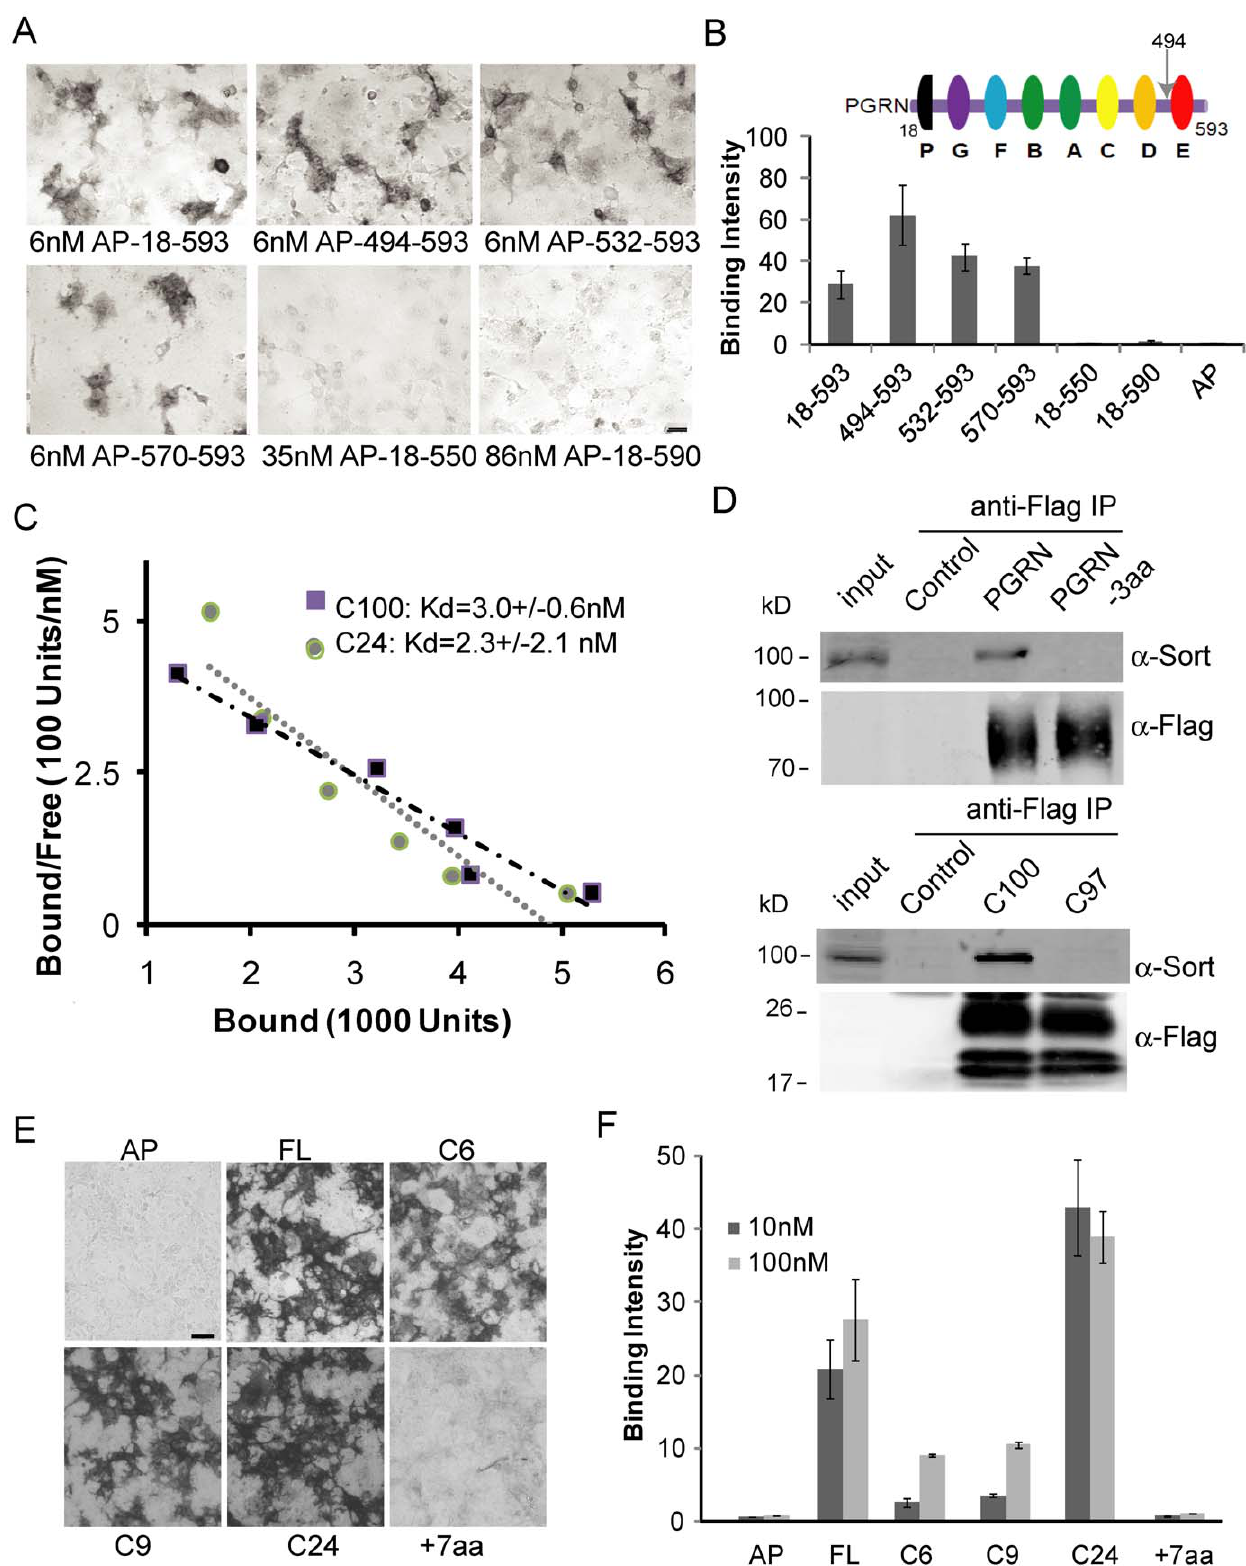
Figure 2. Progranulin C-terminus mediates its binding to sortilin. ( A ) COS-7 cells expressing wild type sortilin were allowed to bind AP tagged progranulin fragments as indicated. ( B ) Quantification of the binding assay as described in (A). The intensity of AP staining was measured using the Metaexpress software (Y axis: average integrated optical density per cell ( 6 100)). ( C ) C24 fragment of progranulin binds to sortilin with a similar affinity as the C100 fragment and full length progrnaulin. Sortilin expressing COS-7 cells were allowed to bind to AP tagged C100 and C24 at